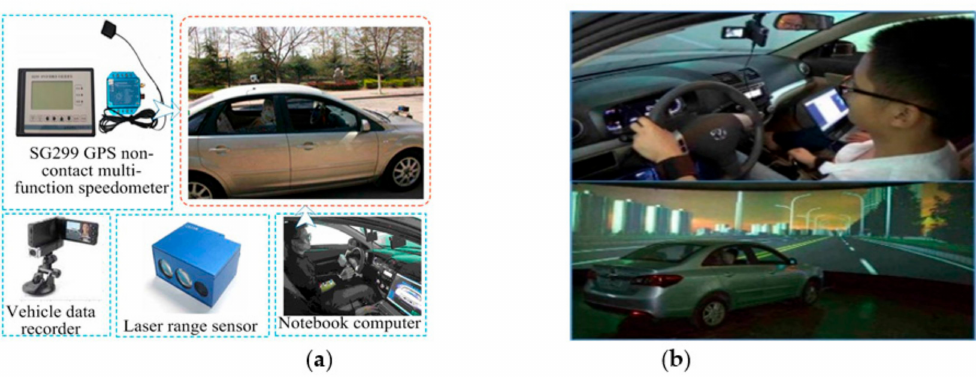
Figure 1. Experiment equipment. ( a ) Actual experiment vehicle; ( b ) Virtual driving